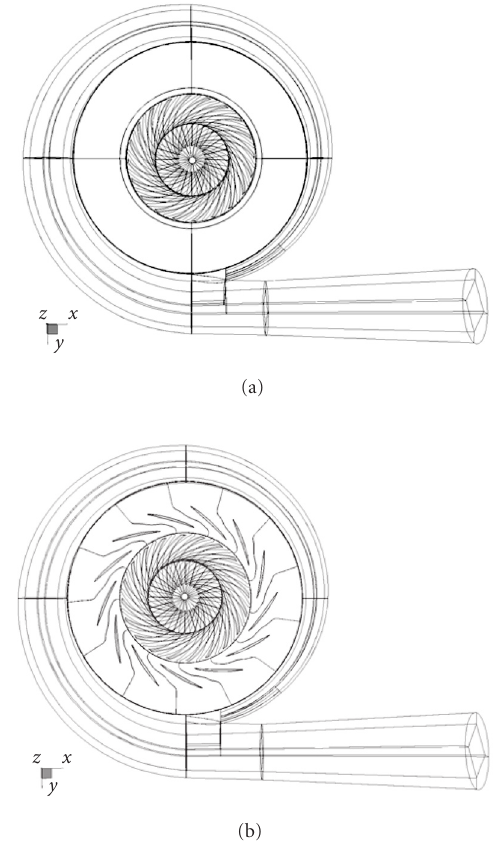
Figure 1: Numerical models of the compressors with the (a) vane- less and (b) vaned di ff users.